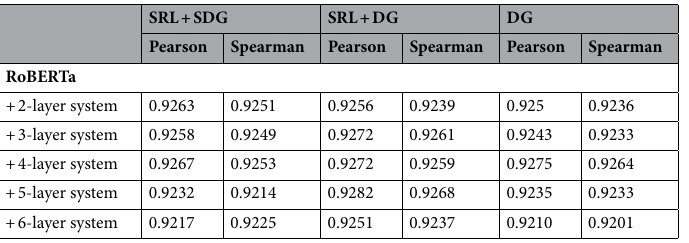
Table 1. Results of the DGNN with various numbers of the levels on top of RoBERTa over SRL + SDG , SRL + DG , and DG graphs in terms of Pearson/Spearman on STS2017/Dev.